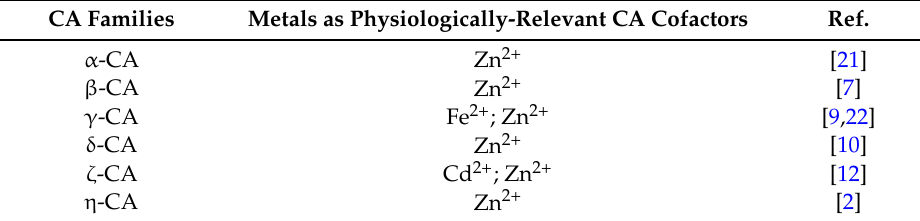
Table 1. Metals as physiologically-relevant cofactors of